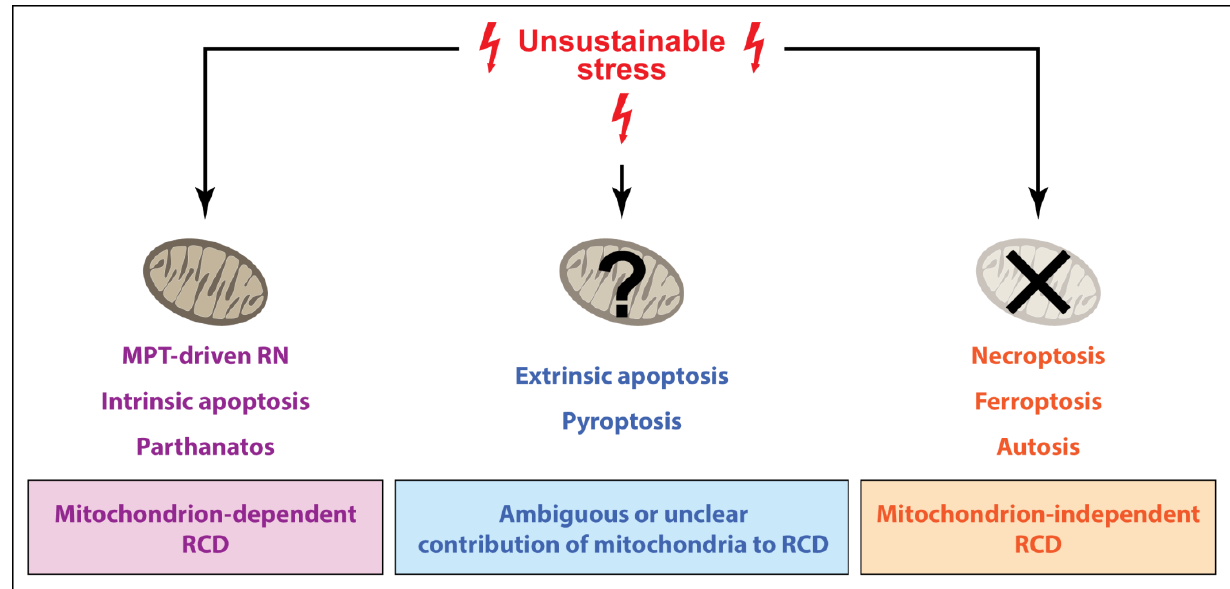
FIGURE 1: Implication of mitochondria in RCD signaling. Mitochondria play a key, non-redundant role in the signal transduction cascades that precipitate intrinsic apoptosis, some instances of extrinsic apoptosis, mitochondrial permeability transition (MPT)-driven regulated ne- crosis (RN), and parthanatos, but are completely dispensable for necroptosis, ferroptosis, and autophagic cell death by autosis (at least ac- cording to current knowledge). The actual contribution of mitochondria to the signaling pathways that drive pyroptotic regulated cell death (RCD) remains to be formally